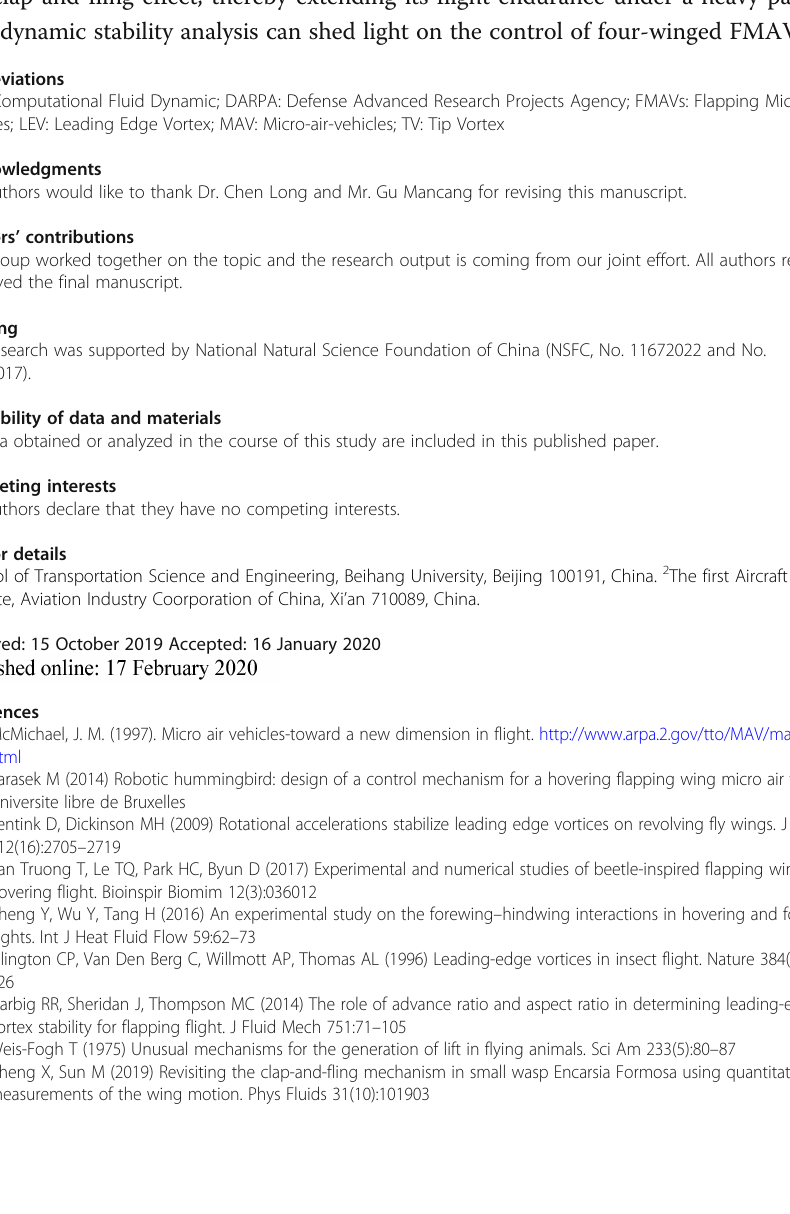
subsidence mode. The divergence speed of the lateral oscillatory divergence mode is about 4 times faster than that of the longitudinal unstable mode. To be specific, the longitudinal oscillatory divergence mode of the four-winged FMAV is doubled over 93.65 strokes, while the lateral oscillatory divergence modes doubles their magnitudes over 21.3 strokes.